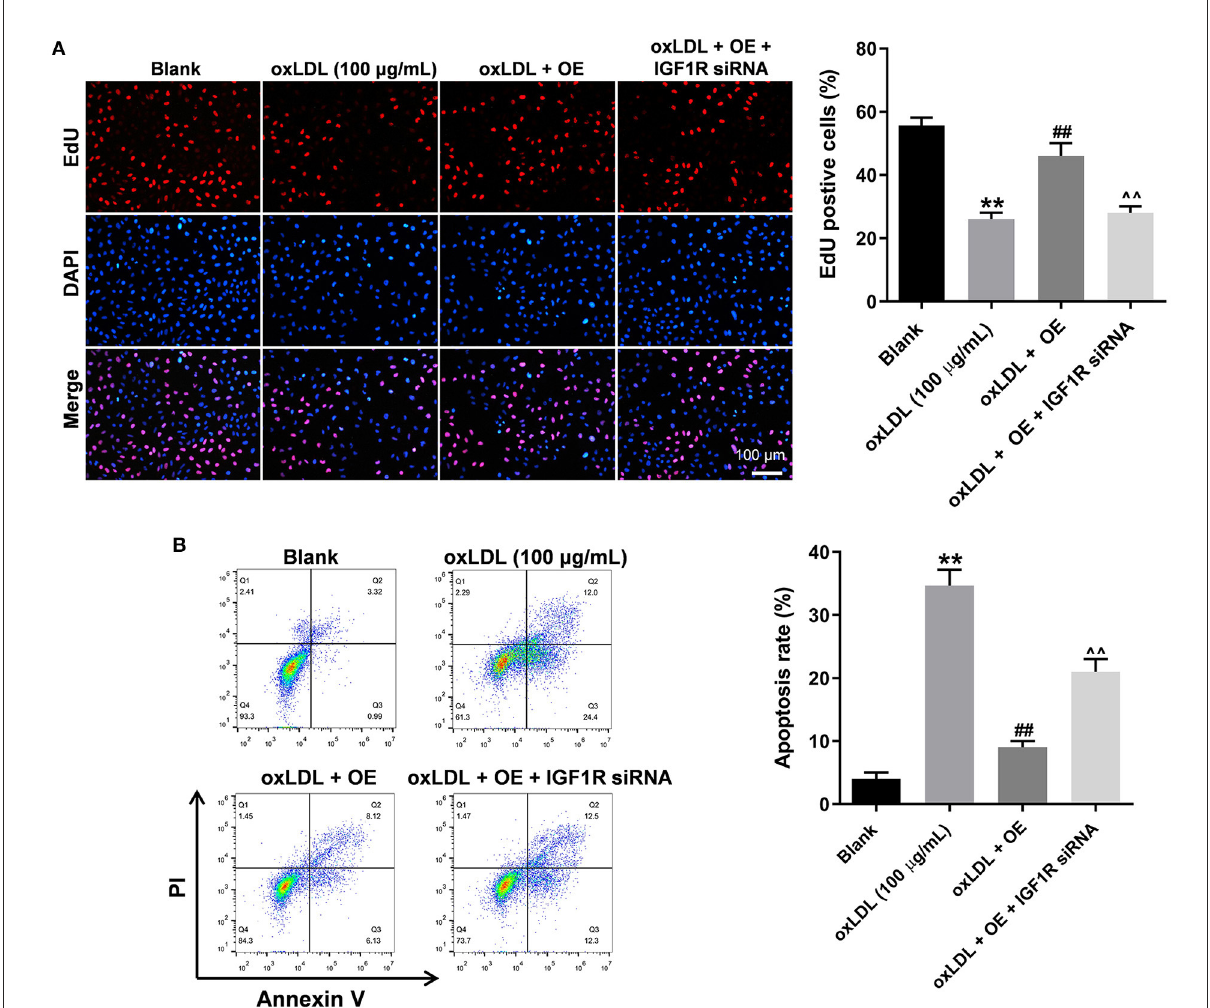
FIGURE5 LINC00452 overexpression reverses oxLDL-induced HUVEC growth inhibition via regulating miR-194-5p/IGF1R pathway. HUVECs were treated with oxLDL (100 µ g/mL) for 24h. Next, HUVECs were transfected with pcDNA3.1-LINC00452 or/and IGF1R siRNA agomir using Lipofectamine 2000 for 24h. (A) EdU assay was performed to detect the proliferation of HUVECs. (B) Flow cytometry assay was performed to detect the apoptosis of HUVECs. ## P < 0.01 compared to oxLDL (100 µ g/mL) group. ∧∧ P < 0.01 compared to oxLDL + LINC00452 OE group, n =